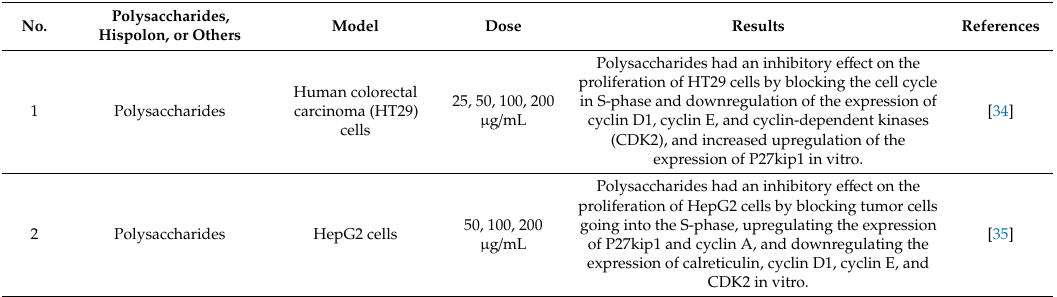
Table 2. The anticancer activity of polysaccharides, hispolon, or others from P. linteus in vitro